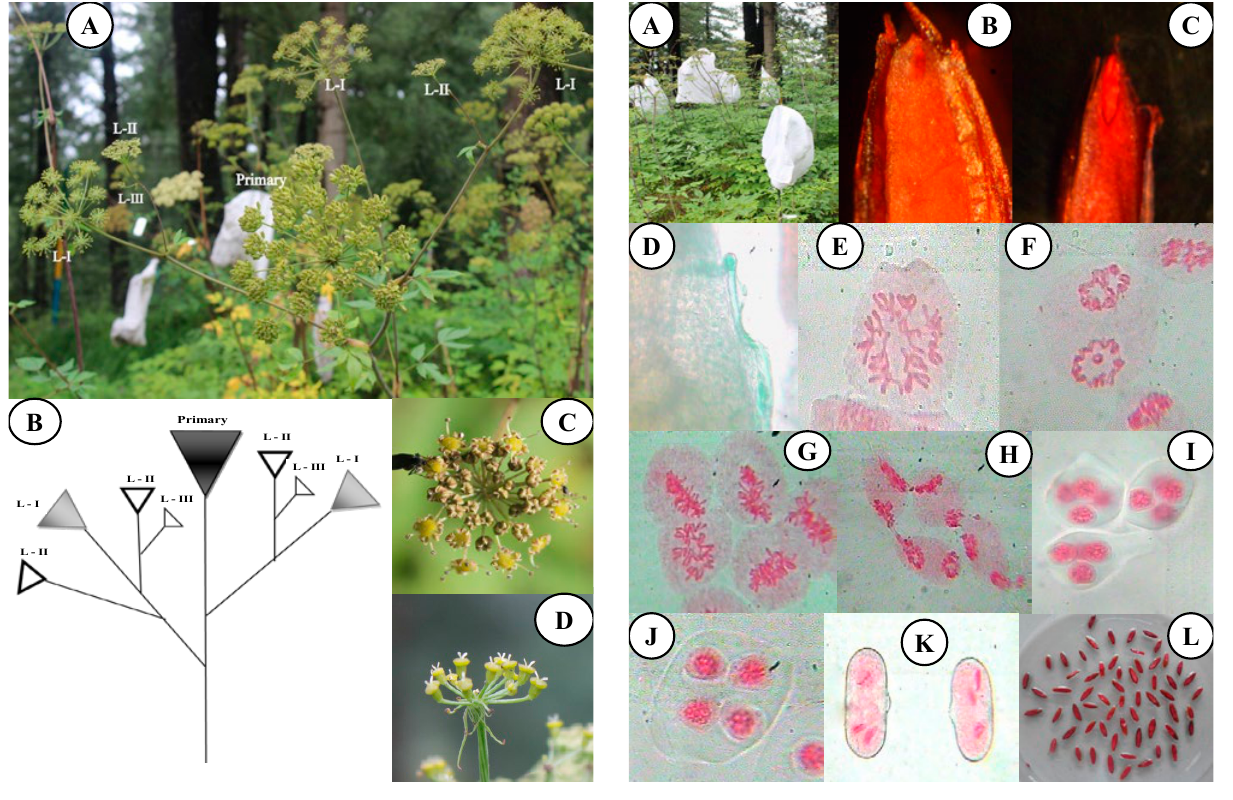
Fig. 2. A. glauca a. Bagging for autogamy; b & c. Seed without and with embryo respectively after TTZ staining; d. Pollen germi- nation on receptive stigma; e. Metaphase-I (n=11, 2n=22); f. Ring formation at poles at anaphase-I; g. Clumping of chromosomes at Metaphase-I; h. Pollen mother cells showing cytomixis i. Decussate and tetrahedral tetrads; j. Isobilateral tetrads; k. Trinucleate pollen grains; l. Seed viability through TTZ